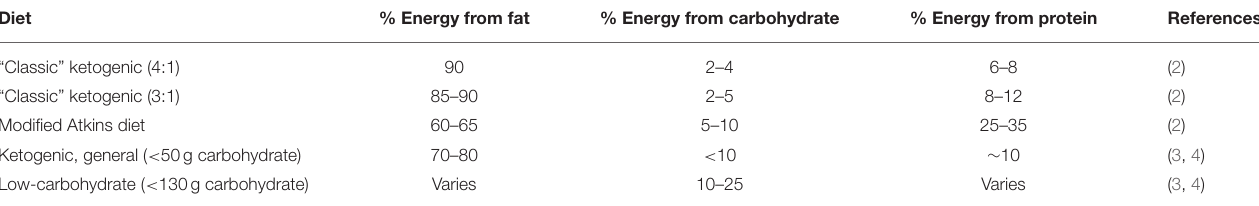
TABLE 1 | Macronutrient composition of ketogenic diets. Diet % Energy from